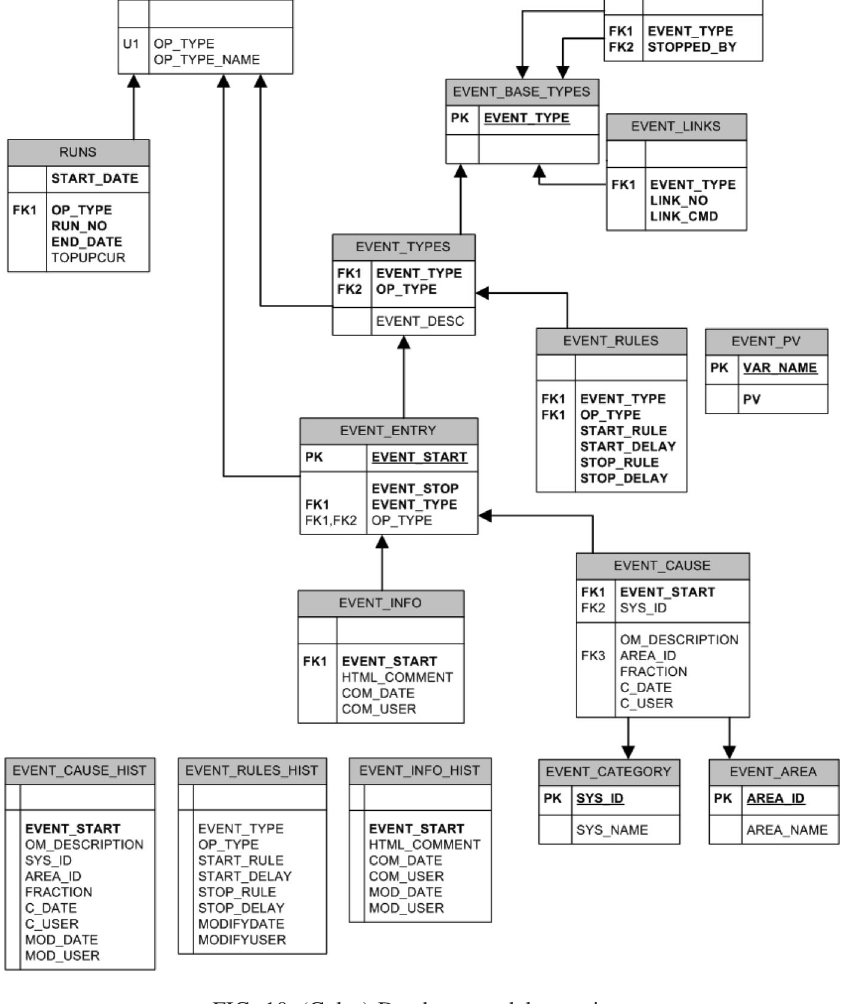
FIG. 10. (Color) Database model